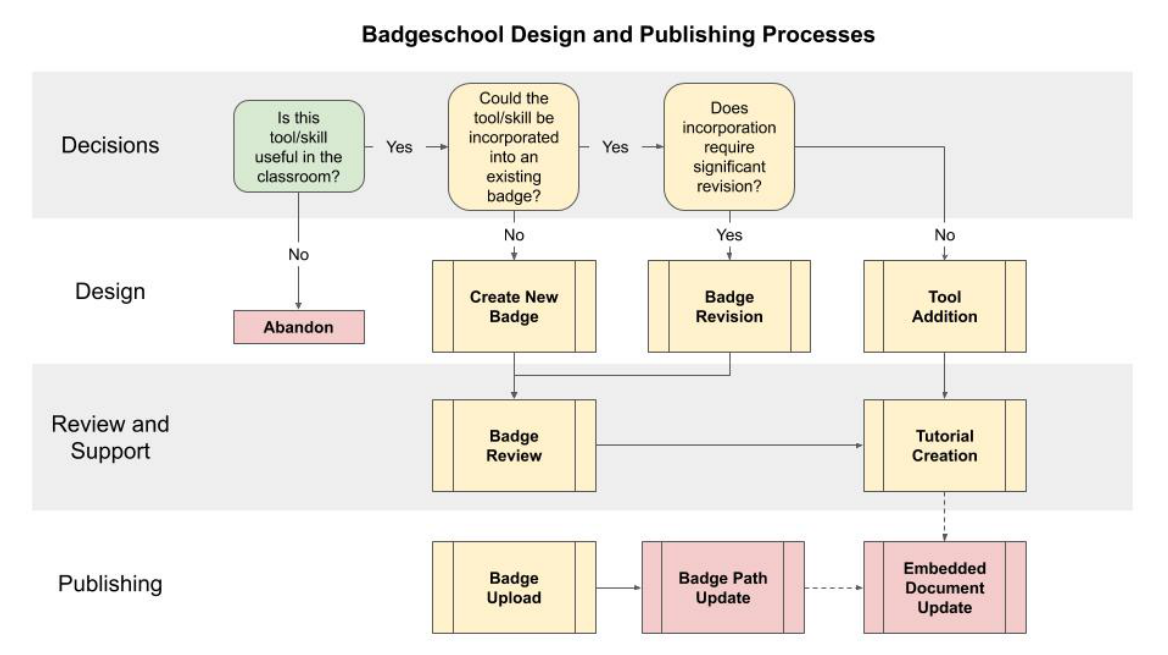
Figure 4. One of many internal Google documents used to scaffold new badge designers. Badge designers were typically teaching assistants in the courses, who had strong content area experience but limited badge design experience, and who were rotated frequently (see Randall,Farmer, & West, 2019).